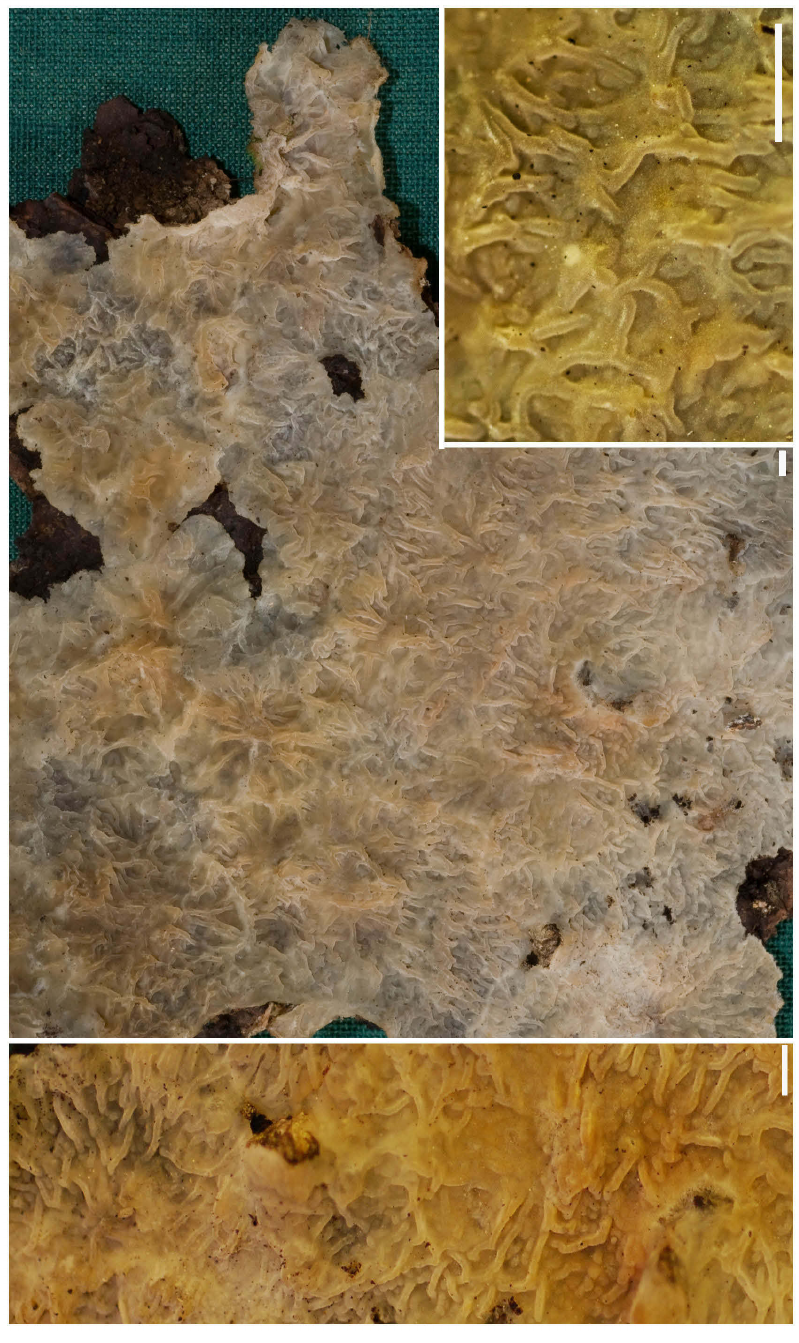
Fig. 1. Aspects of basidiocarp of Phlebia tremelloidea (fresh material; LE 269621) highlighting hymenophoral merulioid folds. Scale bar = 1 mm (photo R.V.